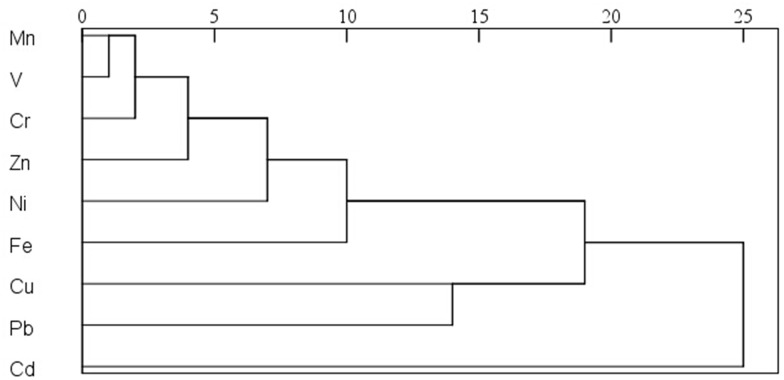
Dendogram of heavy metal concentrations in road dusts of Panzhihua.